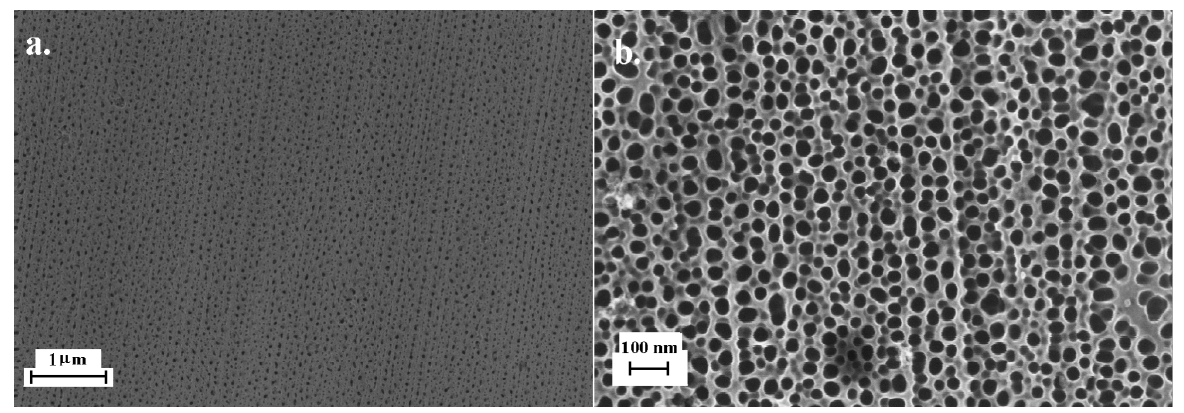
Figure 2: SEM images of the nanoporous alumina film anodized under constant flow conditions.